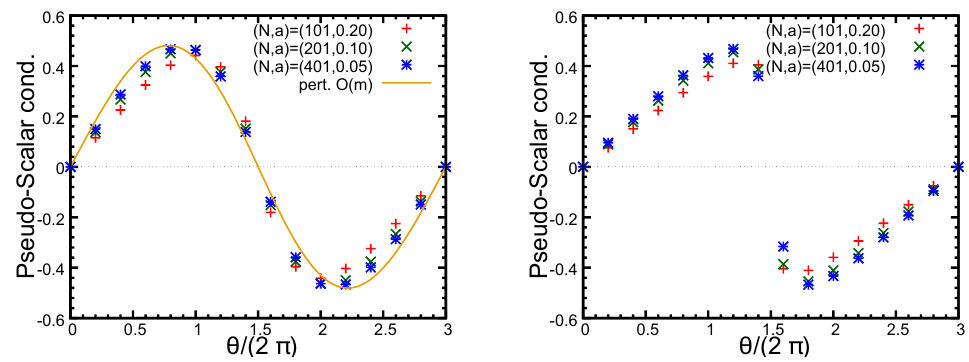
Figure 4 . The local pseudo-scalar condensate P ( n ) at n = ( N − 1) / 2 as a function of θ . The mass parameter from left to right panels is m lat = 0 . 15 and 0 . 60 ,